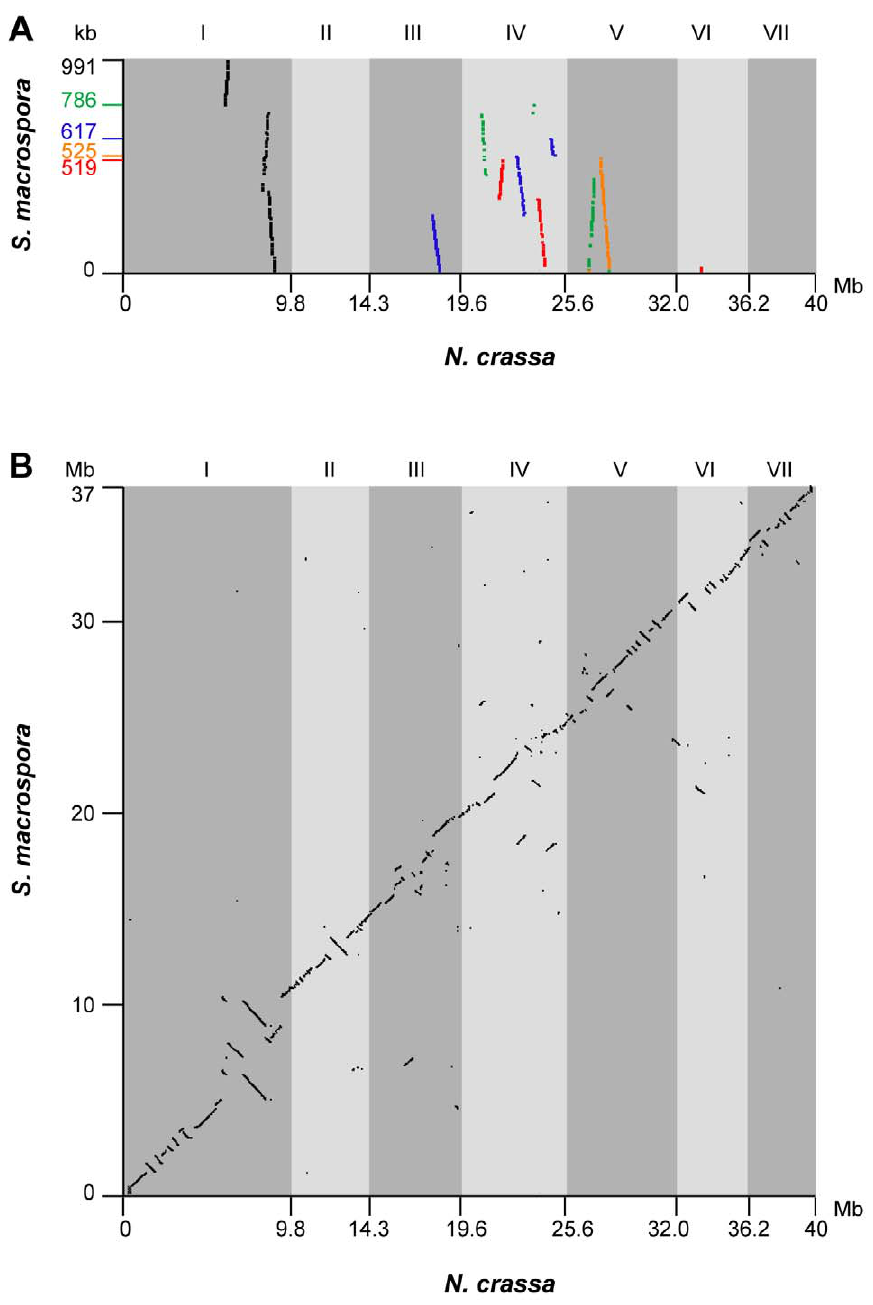
Figure 2. Synteny between the genomes of S.macrospora and N.crassa . (A) Synteny of contigs from the S. macrospora genome with the N. crassa genome before scaffolding along the N. crassa chromosomes. Dot plot of a comparison of the five largest contigs from the Velvet assembly (contigs 3467, 1588, 19727, 3369, and 12432, length given on the y-axis in descending order, total size of the five contigs 3.4 Mb, note that the Velvet contig numbers do not correspond to the contigs of the final assembly) against the Neurospora linkage groups (supercontigs I to VII in finished genome sequence, http://www.broadinstitute.org/annotation/genome/neurospora/Regions.html). The linkage group numbers for N. crassa are given above the dot plot. (B) Dot plot of a comparison of the S. macrospora scaffolds which cover 93% of the genomic sequence against the N. crassa supercontigs corresponding to linkage groups I to VII from the finished genome sequence. Comparisons for both analyses was done with BLASTN with e-value , 10 2 150 . Dot plot visualization was done with Combo two cases, insertions or deletions of 1 nt were found in the this rate is similar to the 0.1–0.001% error rates achieved in microbial draft genomes sequenced by Sanger technology [46,47]. assembled sequence which when corrected led to the prediction of functional open reading frames. In total, we tested 21 kb of coding With 10,789 predicted and partially curated genes, the gene sequence by resequencing and found four insertion/deletion errors count in S. macrospora is similar to that of N. crassa (10,066 (0.02%). Although it is difficult to compare errors and error rates, community-annotated and centrally curated genes). To determine